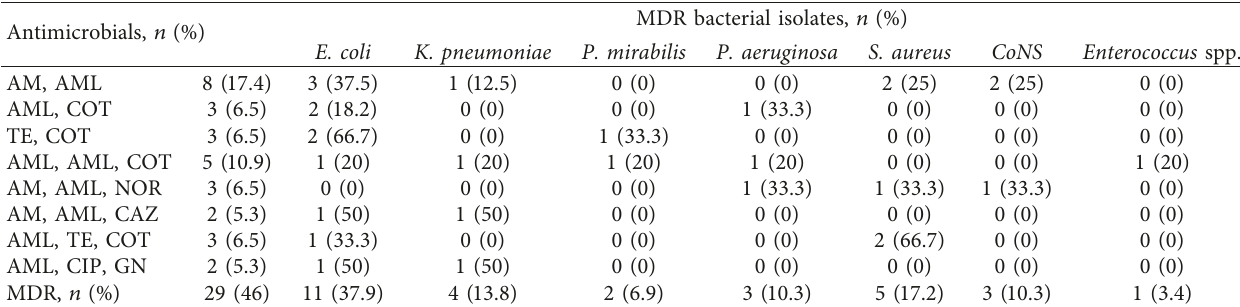
MDR bacterial isolates, n